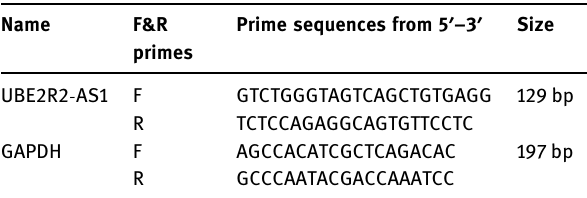
Table 1: The primes sequence in this